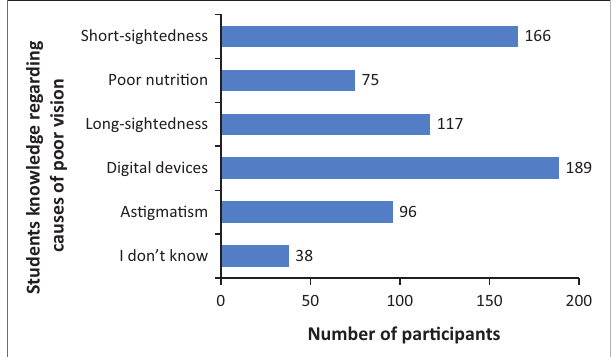
FIGURE 1: Participants perception regarding the causes of poor vision amongst